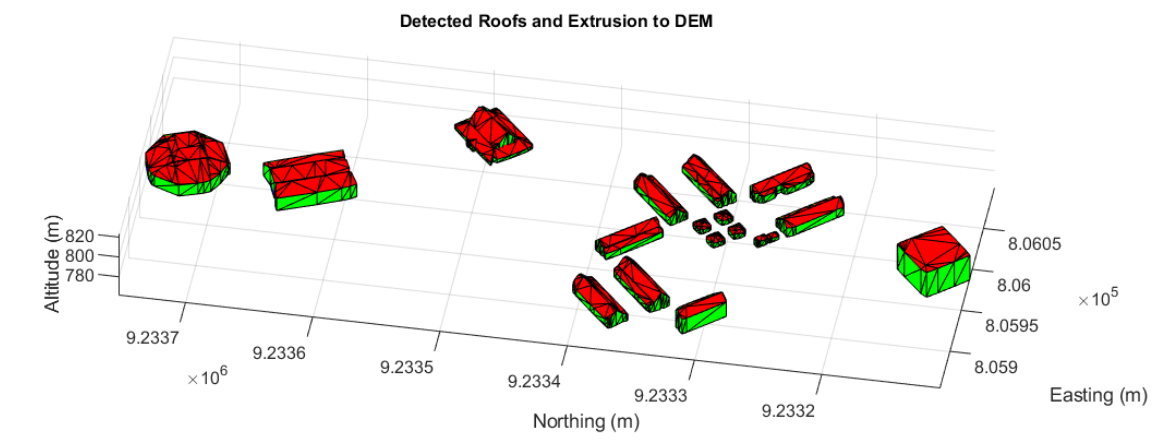
Figure 7. The detected roof 3D polygons with extrusion towards the Digital Elevation Model (DEM).